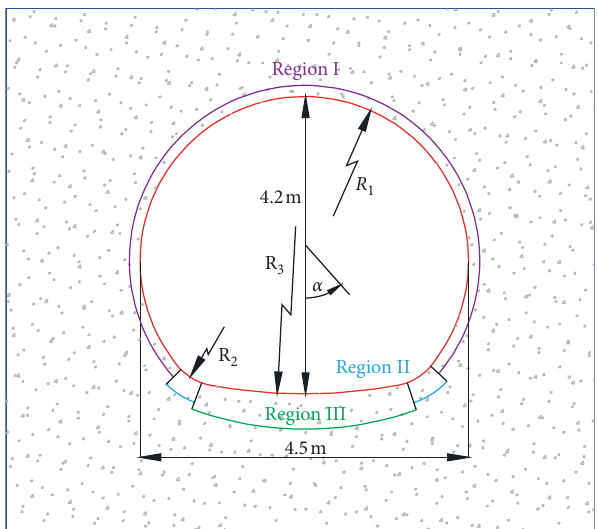
Figure 1: The cross-section diagram of excavated roadway and its partition.